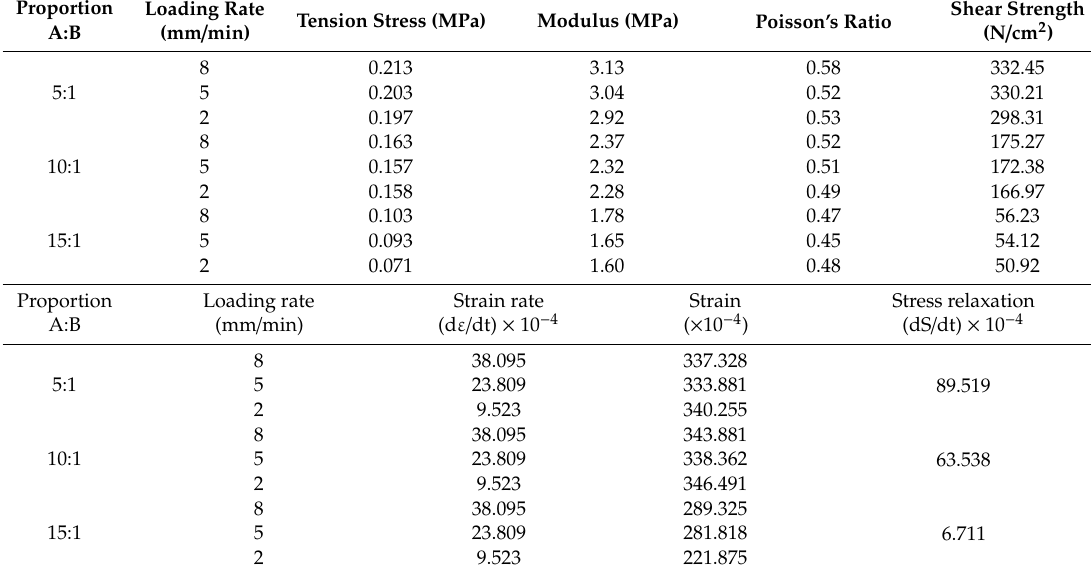
Table 2. Material properties test data under di ff erent (Polydimethylsiloxane, PDMS) mixing ratios (Agent A: Agent B) and test conditions. Proportion